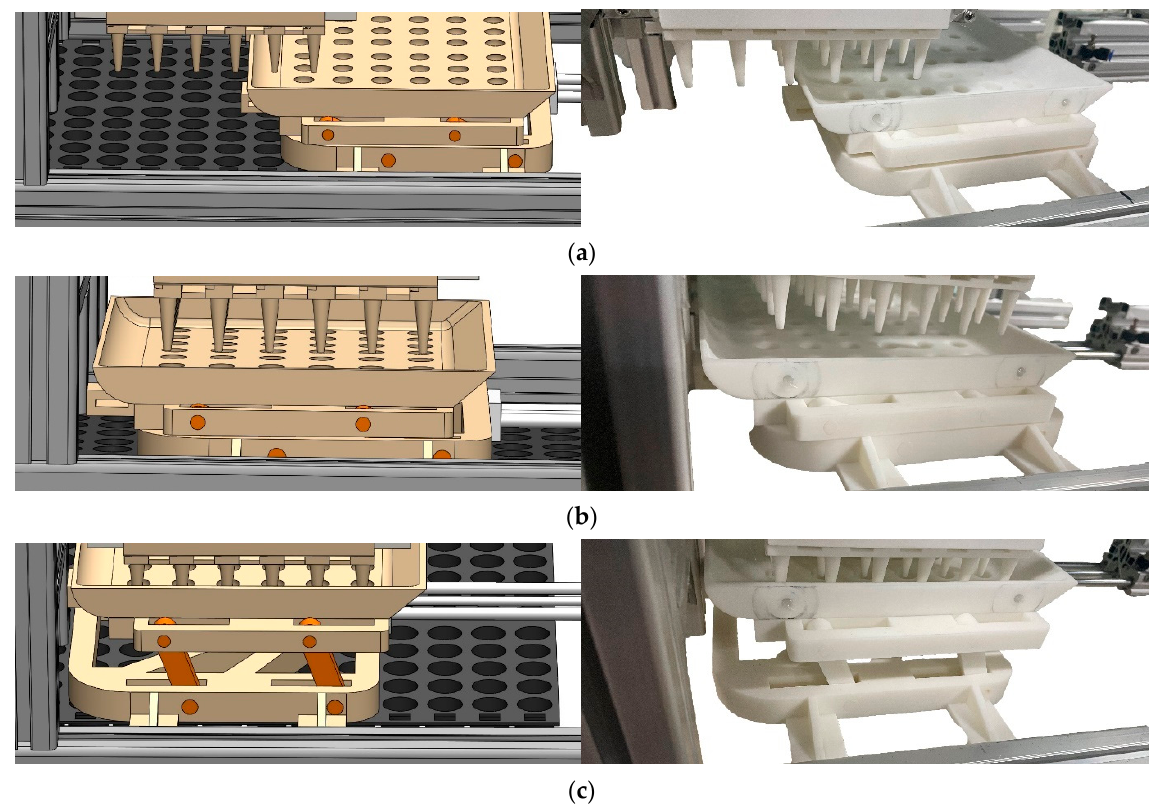
Figure 17. Working process of the liftable sliding seed case. ( a ) Horizontal movement process. ( b ) Front convex block touches the limiter. ( c ) Vertical movement